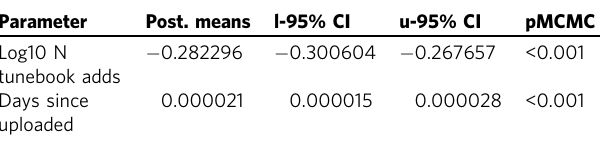
Table 4 Results of regression model predicting Pielou ’ s evenness from log10-transformed popularity ( N tunebook adds) and days since uploaded to the site ( n = 2380 tunes, marginal R 2 = 0.386, normalised RMSE for full model = 0.171, mean normalised RMSE from cross- validation = 0.171, SD = 0.004).